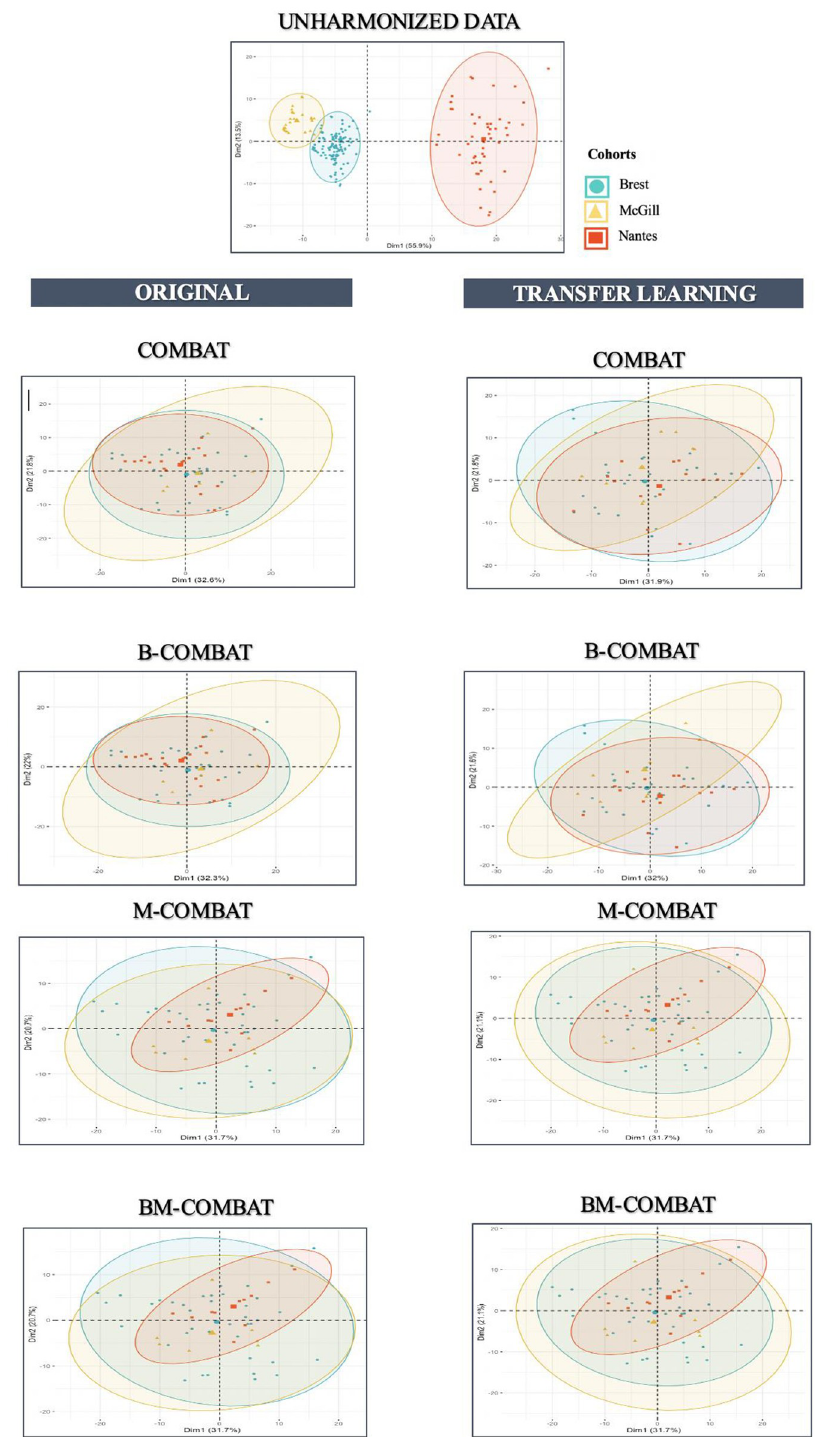
Fig 3. PCA and summary distribution in Experiment 1 in MRI. Scatter plots of top 2 principal components of the radiomic features across the three labels (centers) using data transformed with the 4 versions of ComBat (using R (3.5.1) and R Studio (1.1.456,R Studios Inc., Boston,MA) https://cran.r-project.org/).